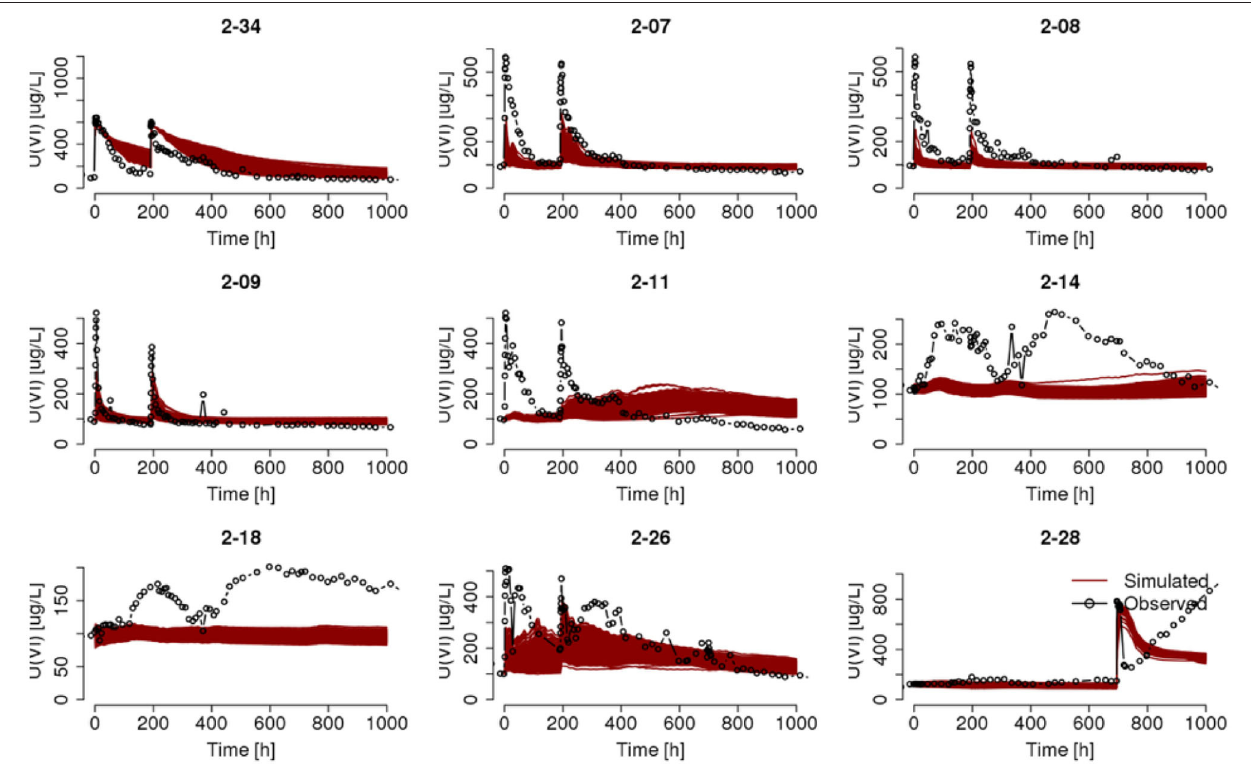
FIGURE 7 | Ensemble of predicted uranium breakthrough curves in selected wells. The best-fit permeability was taken from the posterior ensemble of permeability fields that yielded the conservative tracer breakthrough ensemble in Figure 6 . The sorption site concentration field was generated by conditioning on point data derived from Equation (2). Other plotting specifics are the same as Figure 5